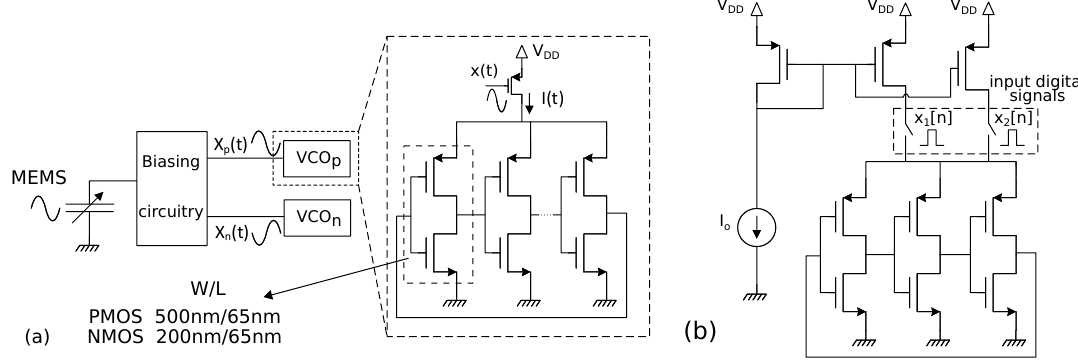
Figure 8. ( a ) Front-end circuit: MEMS, biasing circuitry and first VCOs; ( b ) three-tap digitally-controlled oscillator (DCO) circuit. The sizes for the transistors of the inverters are the same for ( a ) and ( b